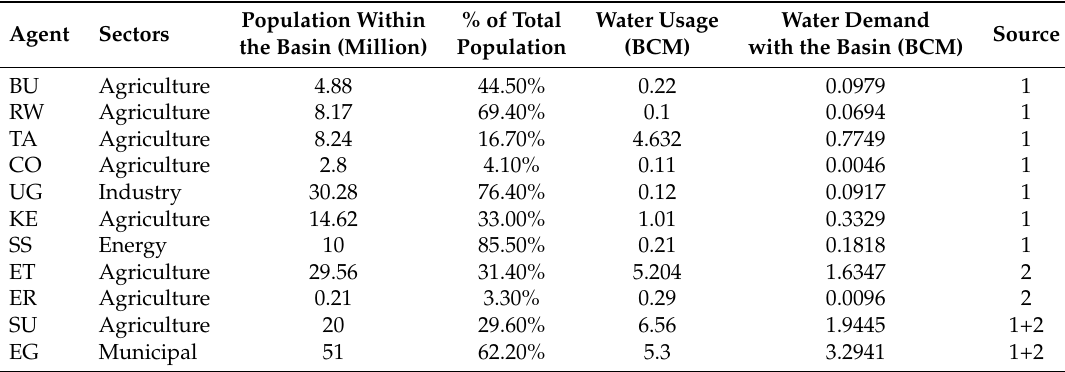
Table 2. Water consumption within the basin [20,22].